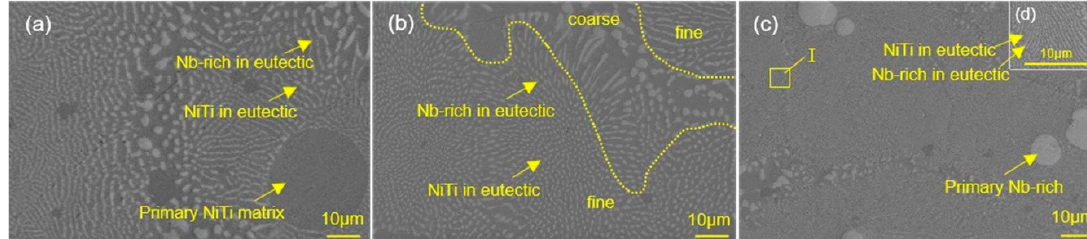
Figure 1. SEM images of Ni41Ti41Nb18 ( a ), Ni40Ti40Nb20 ( b ) and Ni39Ti39Nb22 ( c ) alloys after solution at 850 for 1.5 h, respectively. The inserted image of ( d ) is the corresponding magnified micrographs of region I in ( c ).